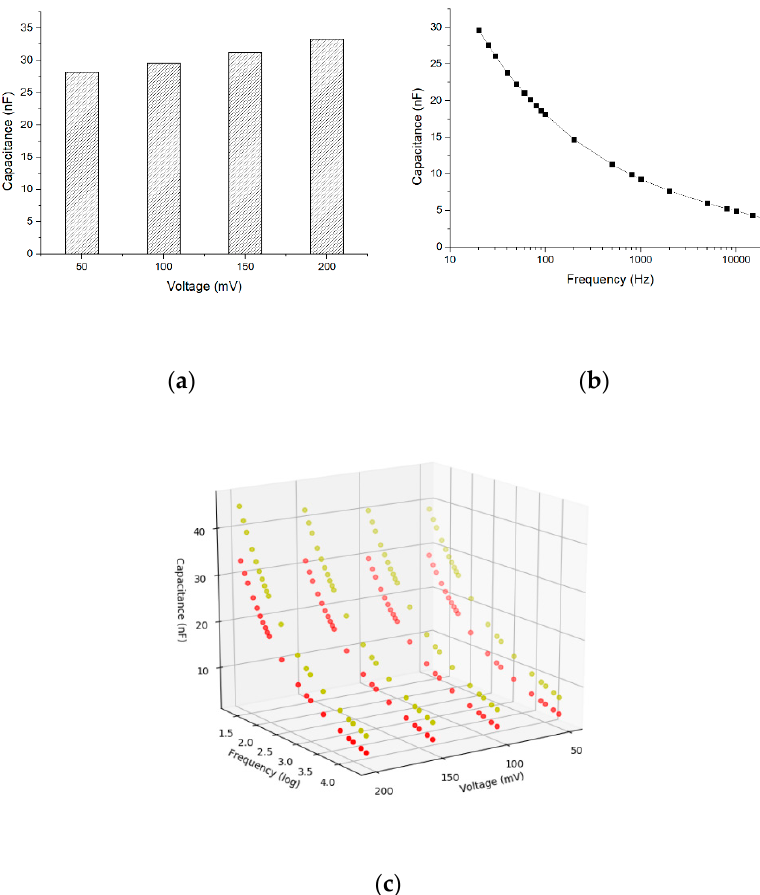
Figure 8. (a) Correlation between capacitance and driving voltages at 20 Hz frequency and 10 6 CFU ∙ mL − 1 ; (b) Correlation between capacitance and frequencies at 50 mV driving voltage and 10 6 CFU ∙ mL − 1 ; (c) 3D plot of correlation between capacitance, frequencies, and driving voltages. The red curve is at cell concentration of 10 5 CFU ∙ mL − 1 while the yellow curve is at 10 6 CFU ∙ mL − 1 . The frequency axis is in logarithmic